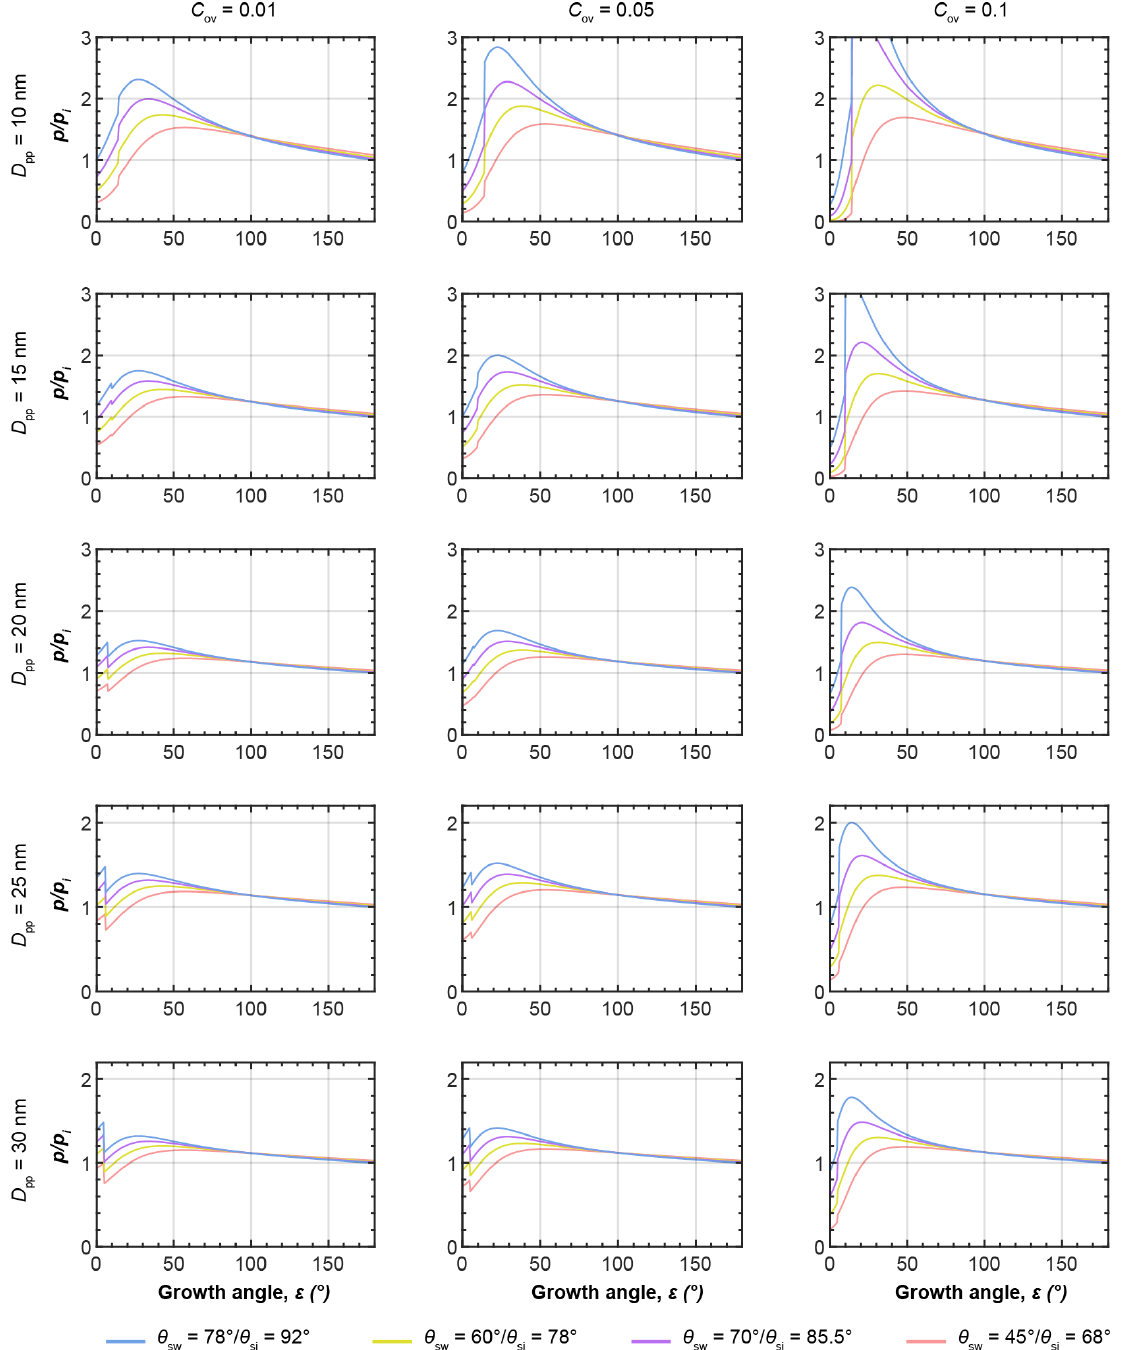
Figure D1. Saturation ratio with respect to ice ( S i = p/p i ) required for (1) filling of three-membered ring pores, followed by (2) growth of pore ice up to the top of the sphere and beyond the height of the three-membered ring pore structure, as detailed in Fig. 6 and described in the main text. The individual panels correspond to different values of the overlap coefficient ( C ov , columns) and primary particle diameters ( D pp , rows). Within each panel the curves correspond to different values of the contact angle between soot and water ( θ sw ) and soot and ice ( θ si ), as indicated in the legend. All calculations were performed for T =